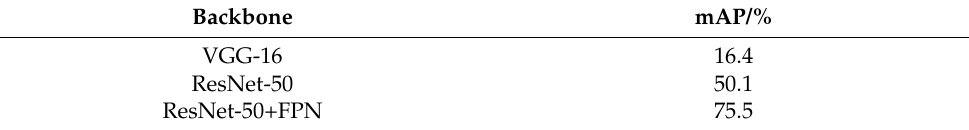
Table 3. Fast R-CNN performance comparison of different backbones on our PSDD datasets.